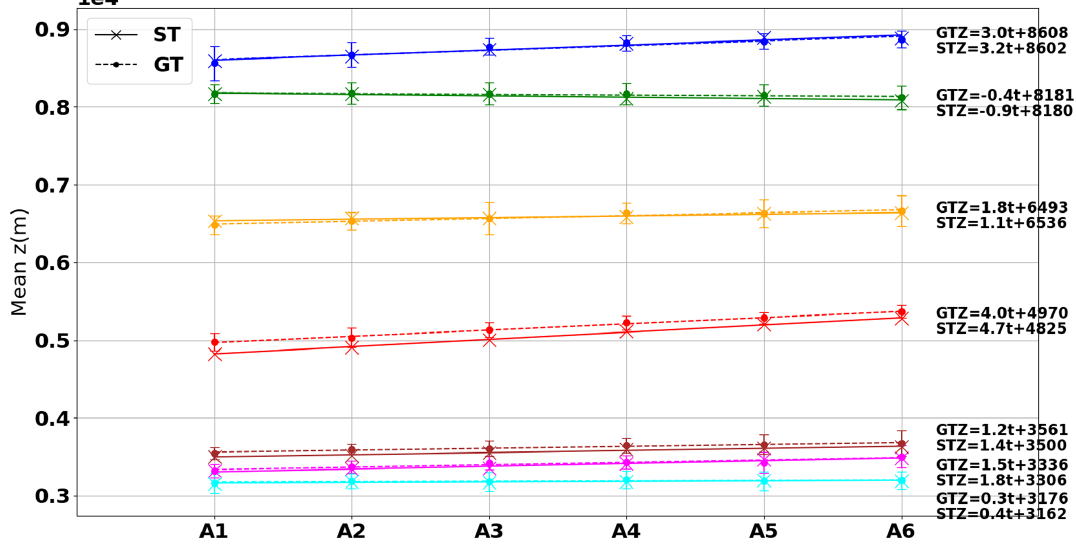
Figure 14. Time series of mean ST Z and mean GT